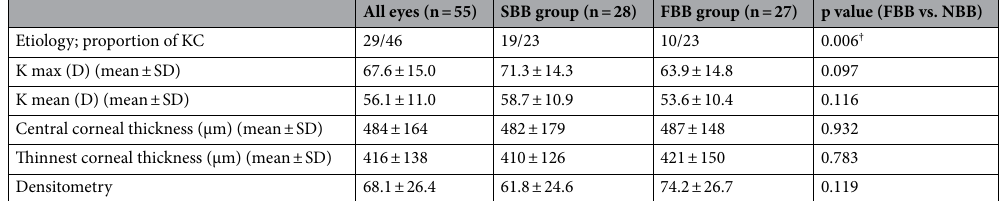
Table 2. Comparison of preoperative biometric values between the SBB and NBB groups. SBB, successful big bubble; FBB, failed big bubble; SD, standard deviation. † Pearson’s chi-square